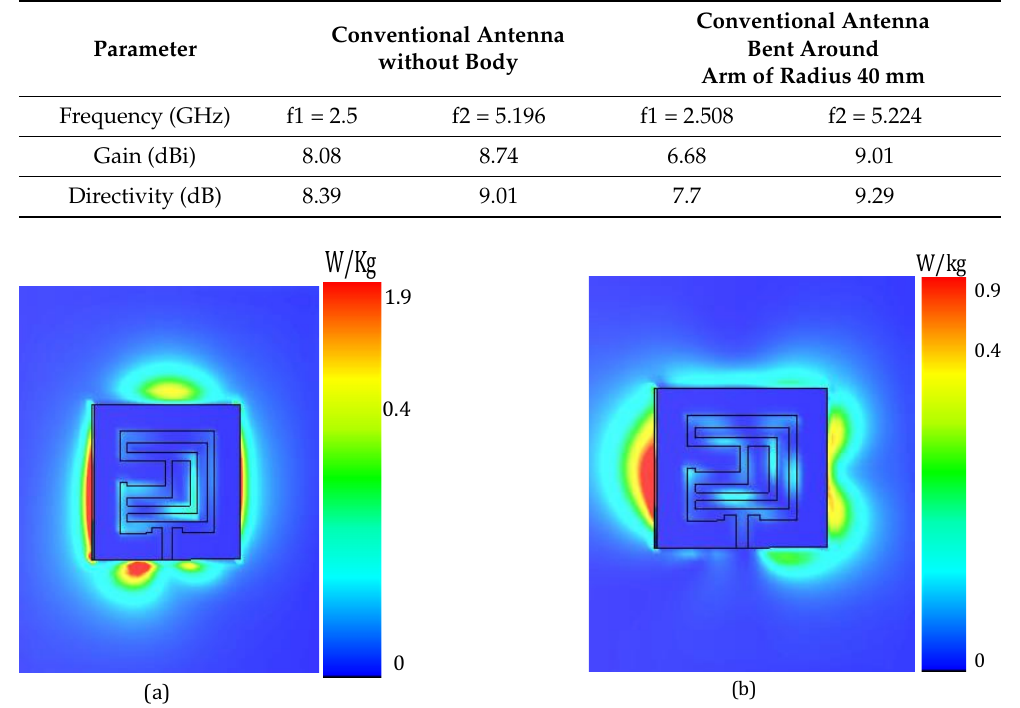
Figure 23. Conventional antenna SAR value on a flat body phantom at ( a ) 2.5 GHz and ( b ) 5.2